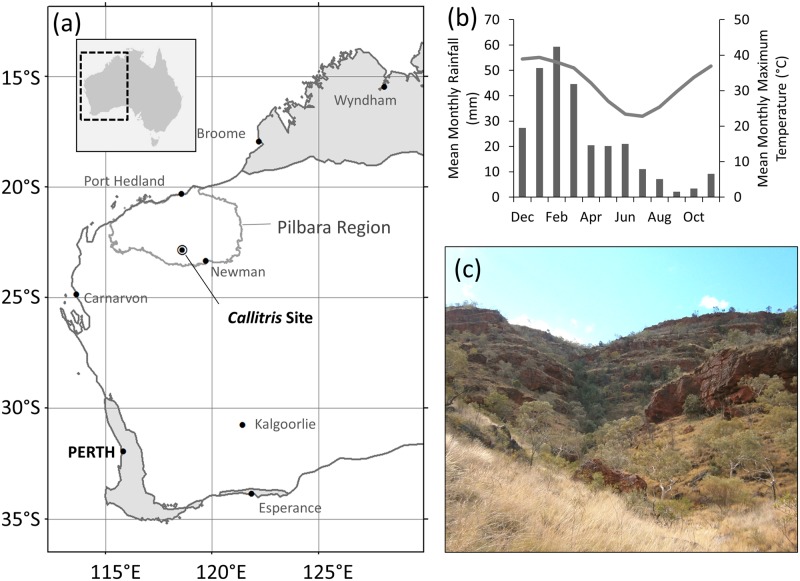
Location and climate of the Callitris tree-ring site.(a) Location of the Callitris site in the Pilbara region of northwest Australia; semi-arid and arid areas of Western Australia are shown in white; the temperate south-west and tropical north of Western Australia are shaded grey. (b) Long-term (1901–2012) mean monthly precipitation (bars) and maximum temperature (line) of the northwest region (i.e., CRU version 3.22 data area-averaged over 117–122°E, 21–26°S, see methods for details). (c) The tree ring site; a shallow, south-facing gully in the Hamersley Range. Dark green/grey trees visible in the centre of the image are Callitris columellaris, lighter-coloured trees are Eucalyptus leucophloia, and grasses in foreground and along the slopes are predominantly Triodia spp.